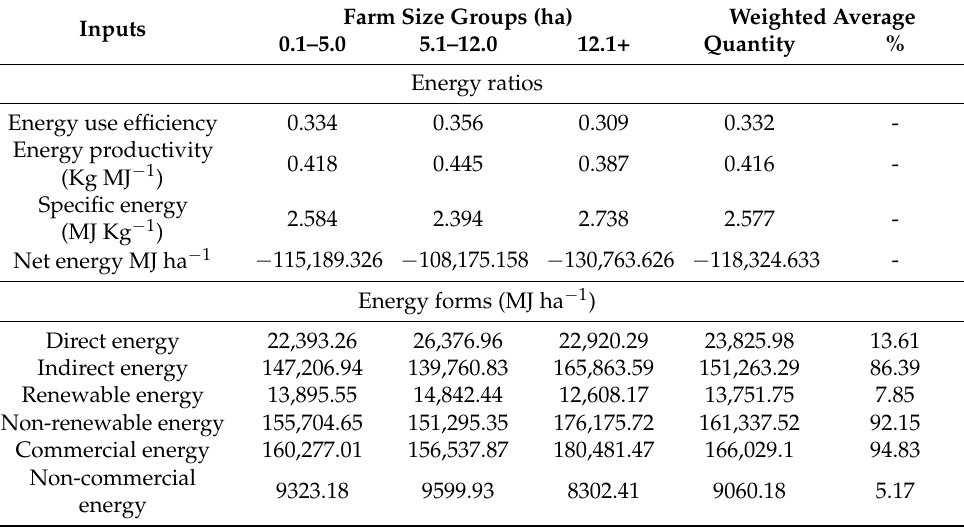
Table 4. Input–output energy ratios and energy forms in off-season tomato